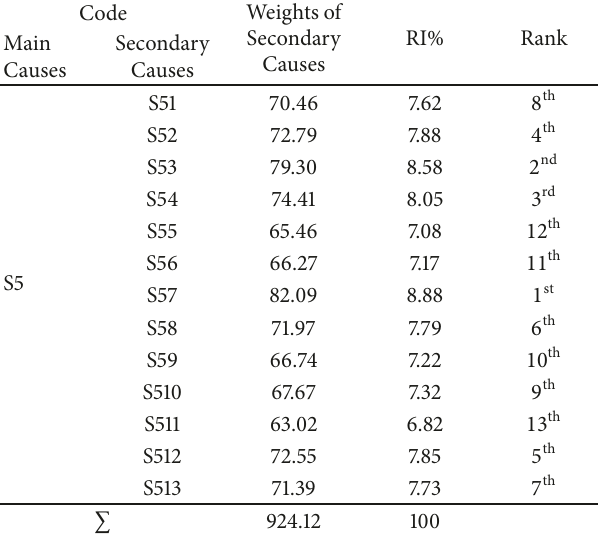
Table 8: Main causes weights, relative importance, and rank for project executing and monitoring management process